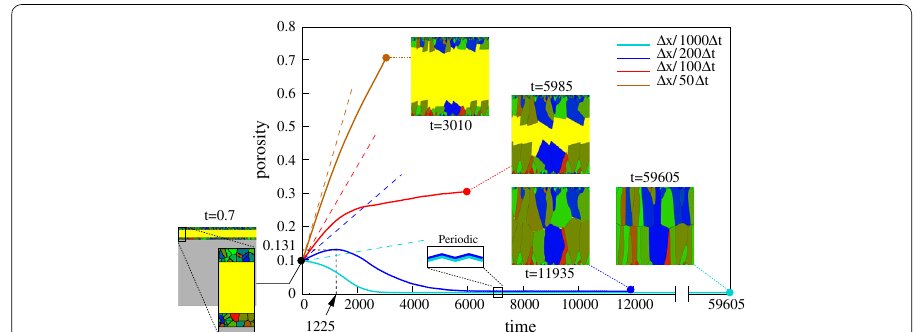
Fig. 5 Temporal evolution of fracture porosity for different crack opening rates represented by different colored solid lines. The same colored dashed lines depict the porosity-time behavior in the absence of cement growth, signifying constant crack opening rates. The inset picture illustrates the initial and final vein morphologies at the end of